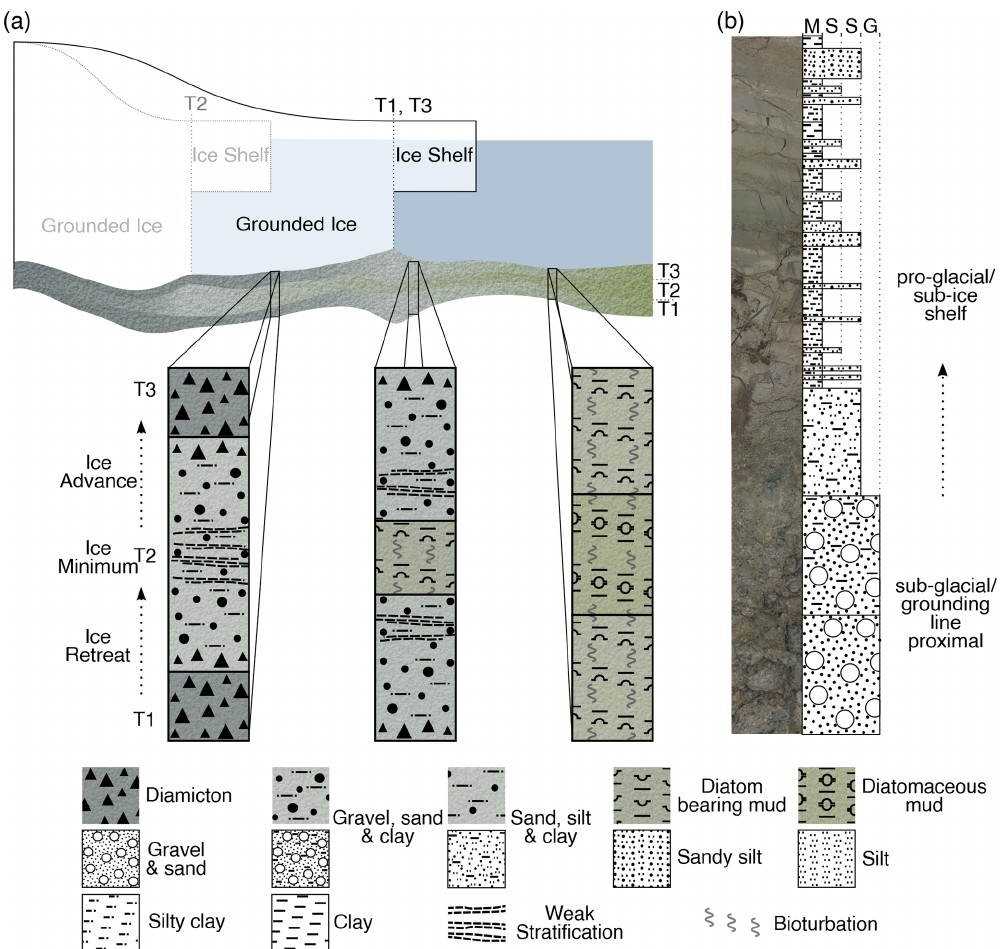
Figure 3. Facies changes in marine sediments that would be consistent with readvance. (a) Illustration of sediment logs recording an interval of reduced glacier extent (T2) between more advanced glacier positions (T1 and T3) for sub-glacial, glacio-proximal, and glacio-distal settings. (b) Example of sediment transition from a sub-glacial/grounding-line-proximal to proglacial/sub-ice-shelf